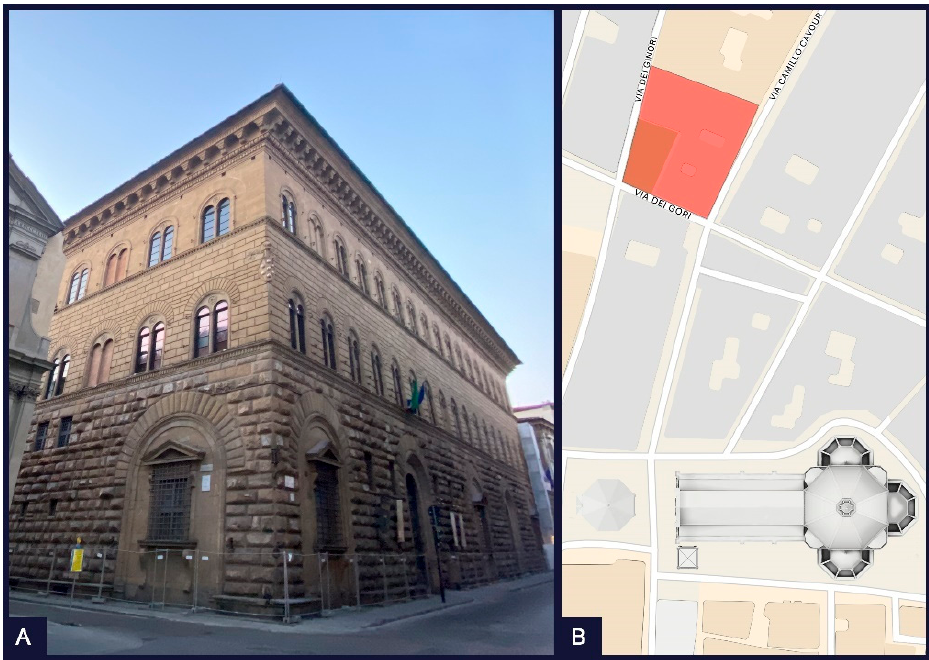
Figure 2. ( A ) Representation and ( B ) location of Palazzo Medici Riccardi.